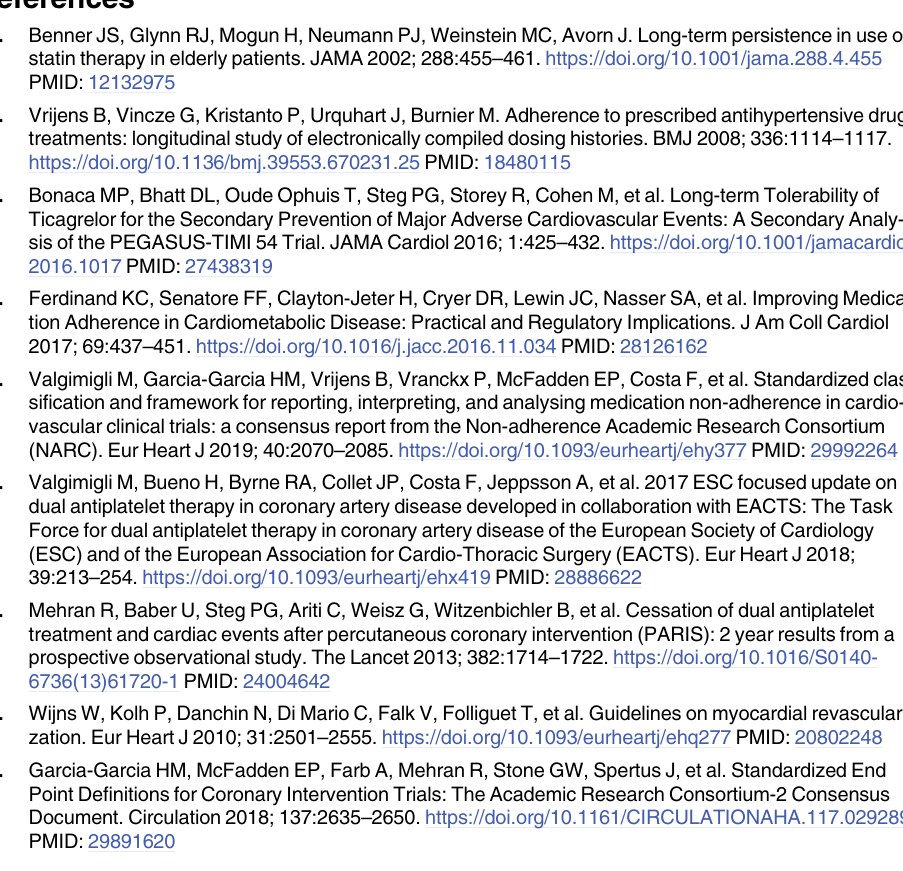
S3 Table. Baseline characteristics according to PARIS category. S4 Table. Non-adherence according to PARIS category. S5 Table. Event rate at 1 year according to PARIS